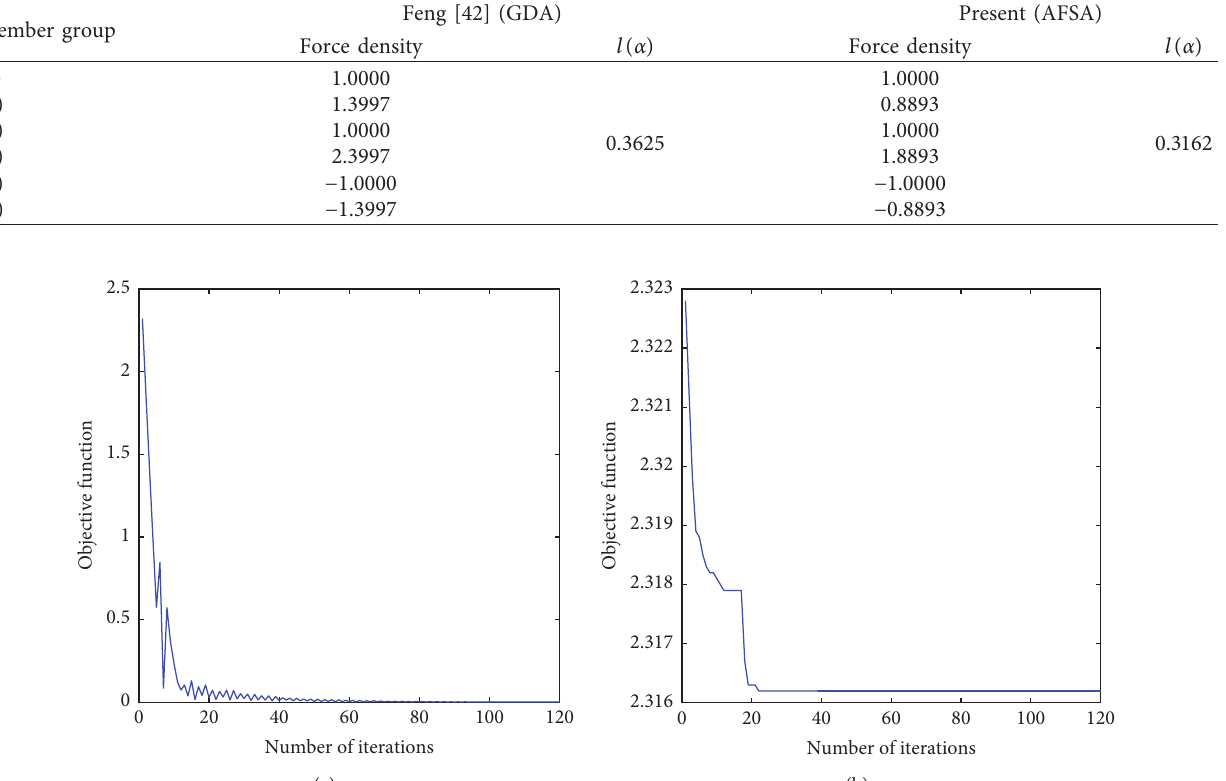
Figure 3: Convergence processes of the objective function for the planar tensegrity grid beam. (a) Reference [42] (GDA) and (b) present